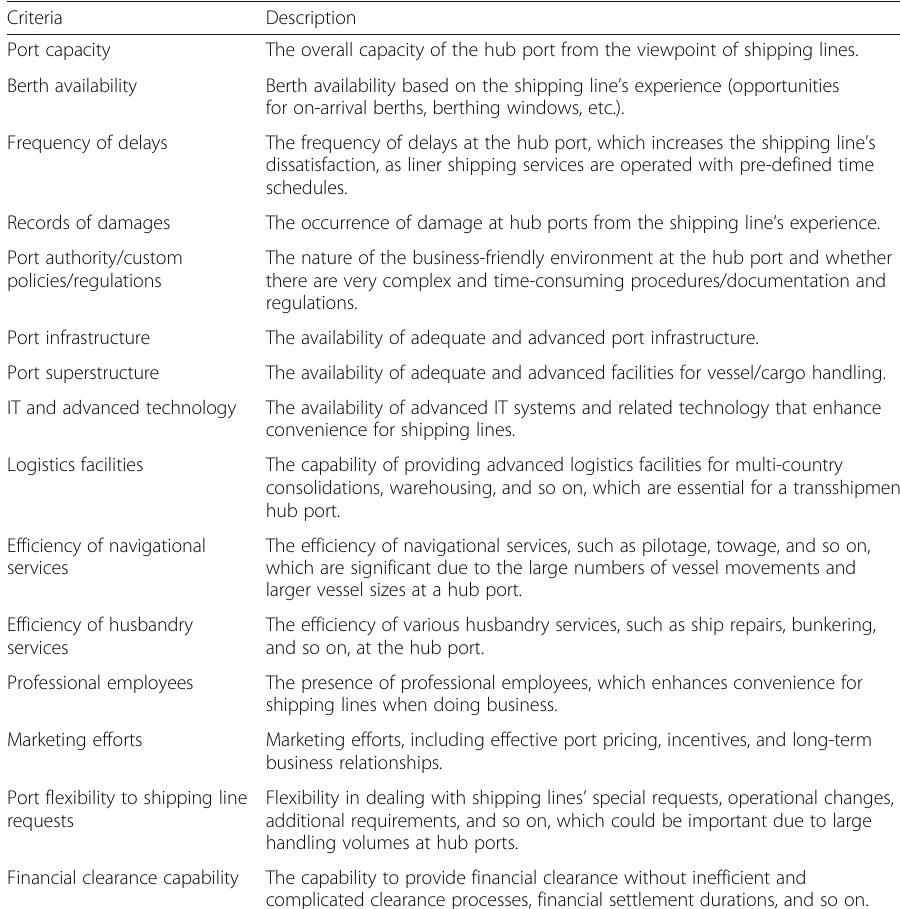
Table 6 Criteria Related to the Operation Category Criteria